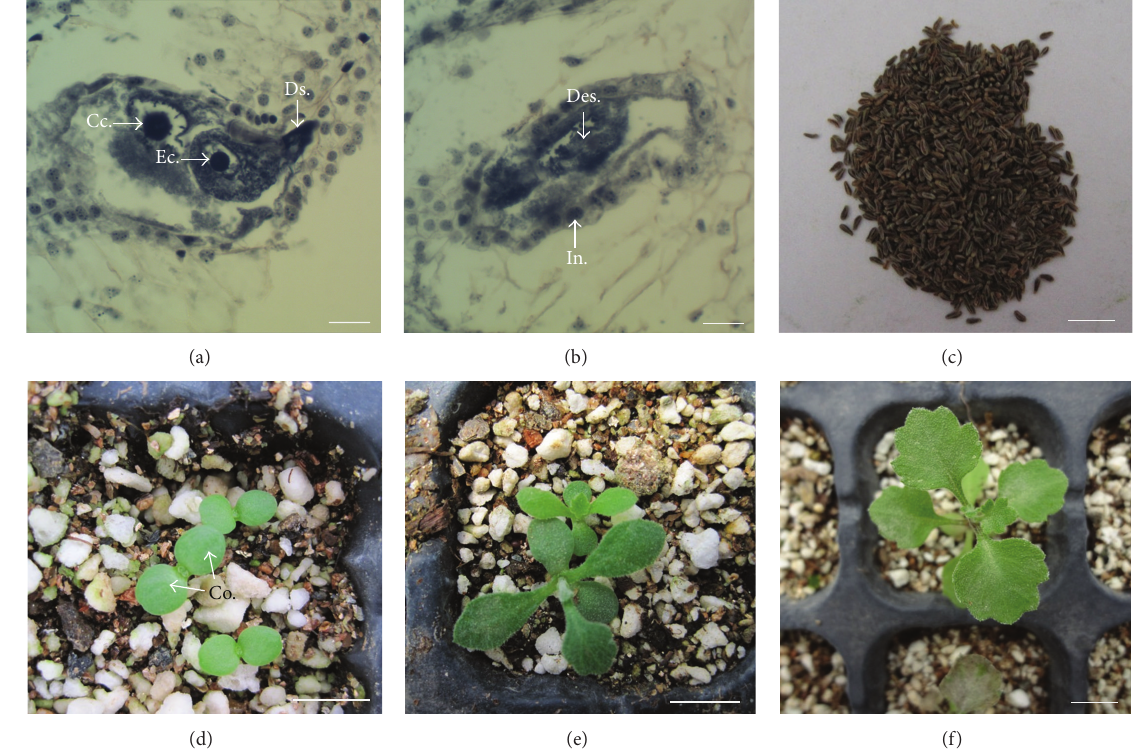
Figure 2: Ovary anatomy, seeds, and seedlings of chrysanthemum. (a) An unfertilized embryo sac at two weeks after self-pollination. (b) A degenerative embryo sac at two weeks after self-pollination. (c) Self-pollinated seeds of “Q10-33-1.” ((d), (e), and (f)) Progeny of self-pollinated “Q10-33-1” at different growth stages. Abbreviations: Cc.: central cell, Co.: cotyledon, Des.: degenerative embryo sac, Ds.: degenerative synergid, Ec.: egg cell, and In.: integument. Bars: 100 𝜇 m ((a) and (b)) and 1cm ((c)–(f)).